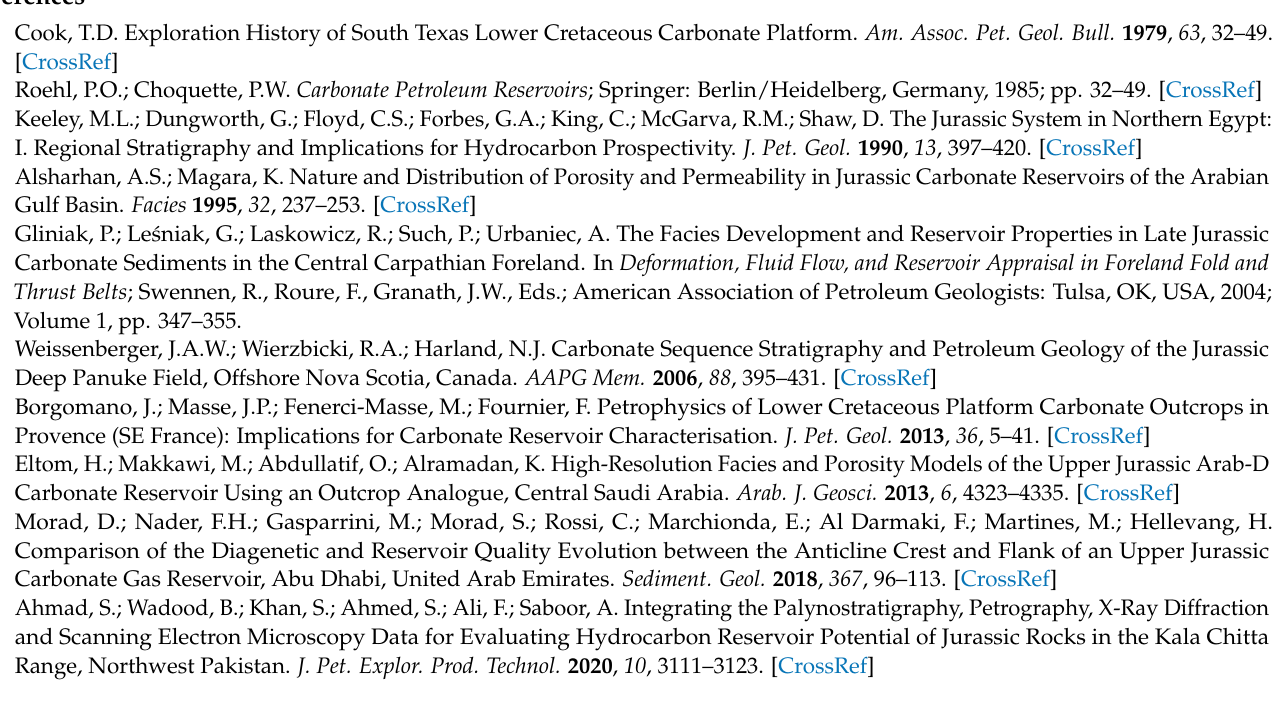
Figure S2: Detailed sequence stratigraphy and tectonostratigraphy